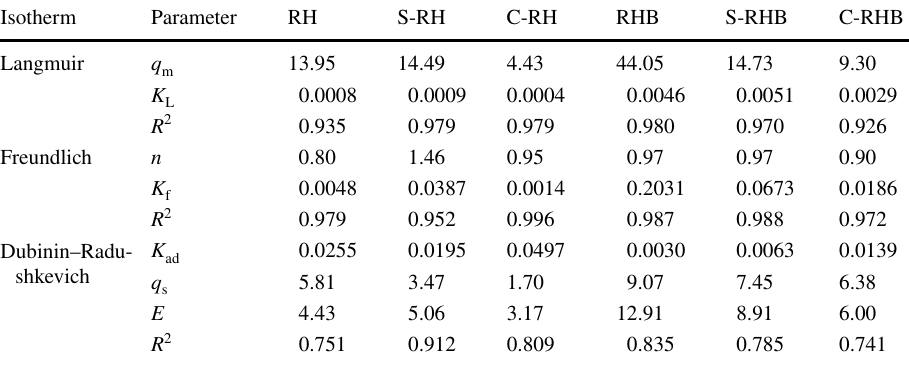
of ammonium 30–3000 mgN/l onto rice husk, rice husk biochar, and their modification with CTAB and SDBS surfactant at 25 ± 1 °C, initial pH of 7.0 ±